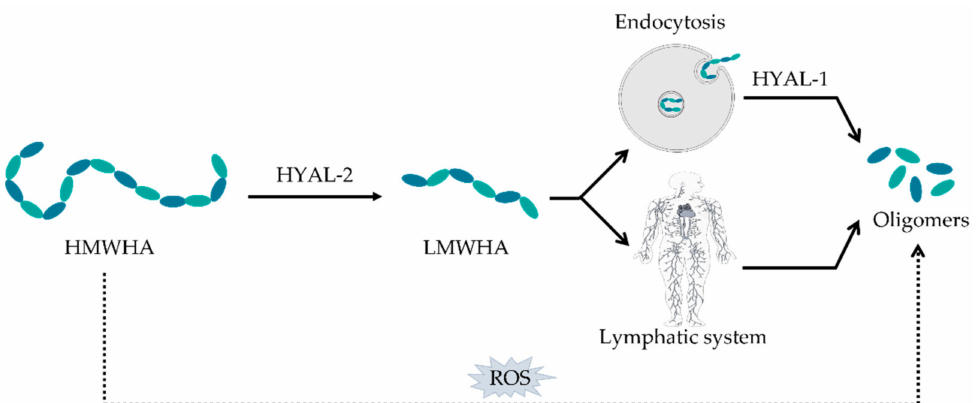
Figure 3. Representative scheme of enzymatic and ROS degradation of